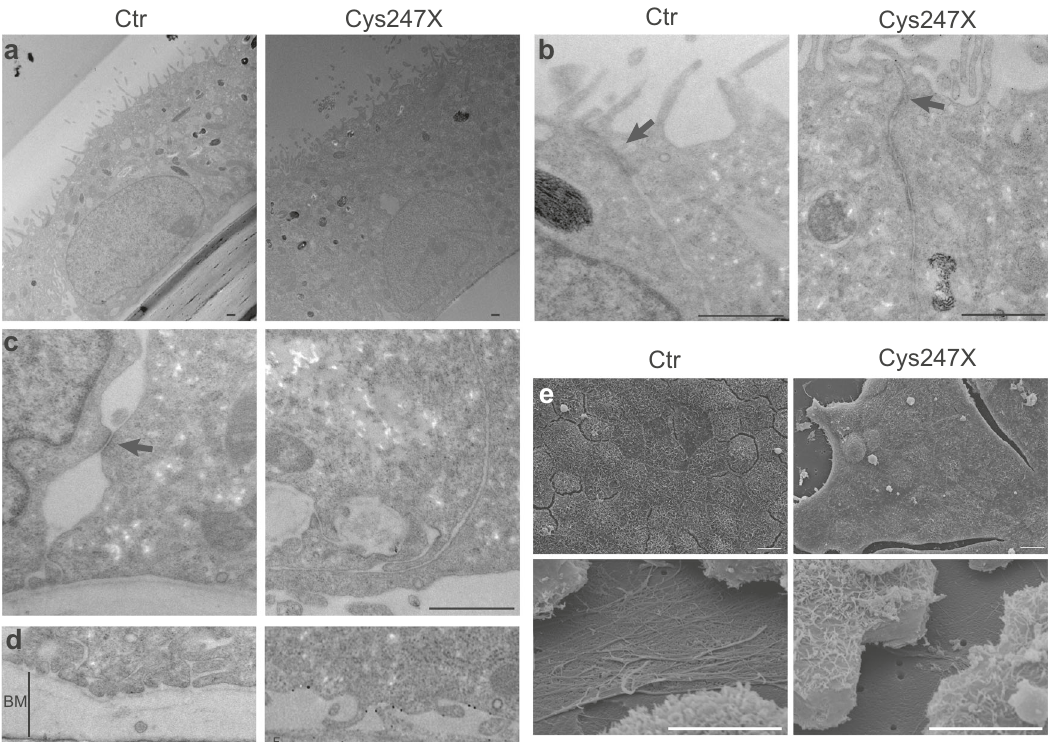
Fig. 2 Electron microscopic analysis of control and PRPF31 -mutated iRPE cells. a – d Transmission electronic microscopic images showed the presence of apical microvilli ( a ), basal nuclei ( a ), tight junctions ( b , arrows) in both control (Ctr) and Cys247X iRPE cells, and the presence of desmosomes ( c , arrow) and basal membranes ( d , vertical line BM) only in Control iRPE cells. Scale bar = 1 µm. e Scanning electron microscopic images showed the presence of apical microvilli in both Control and Cys247X iRPE cells (upper panels) and the absence of basal membrane in Cys247X iRPE cells (lower panels). Scale bar = 10